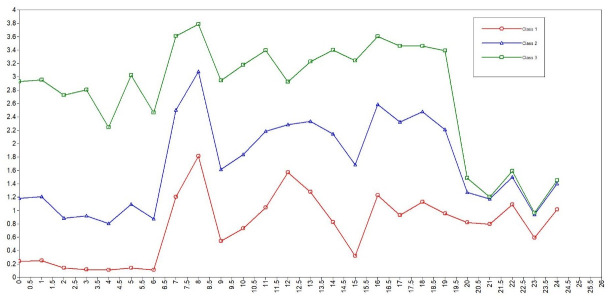
The distribution of three potential classes with different participation levels.